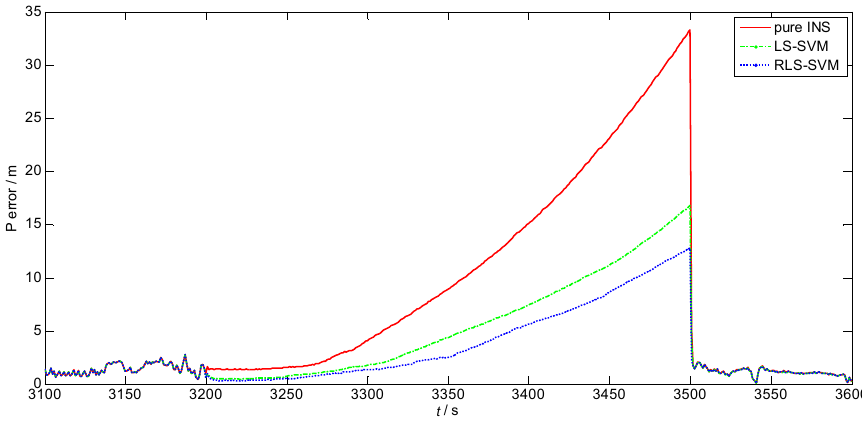
Figure 4. Position errors among different algorithms.